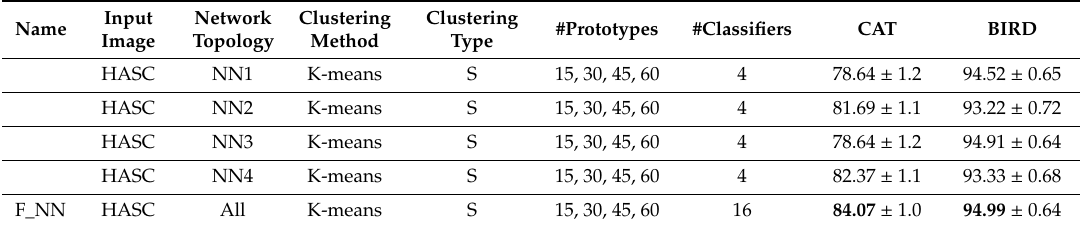
Table 4. Performance obtained considering di ff erent network topologies: accuracy ± standard